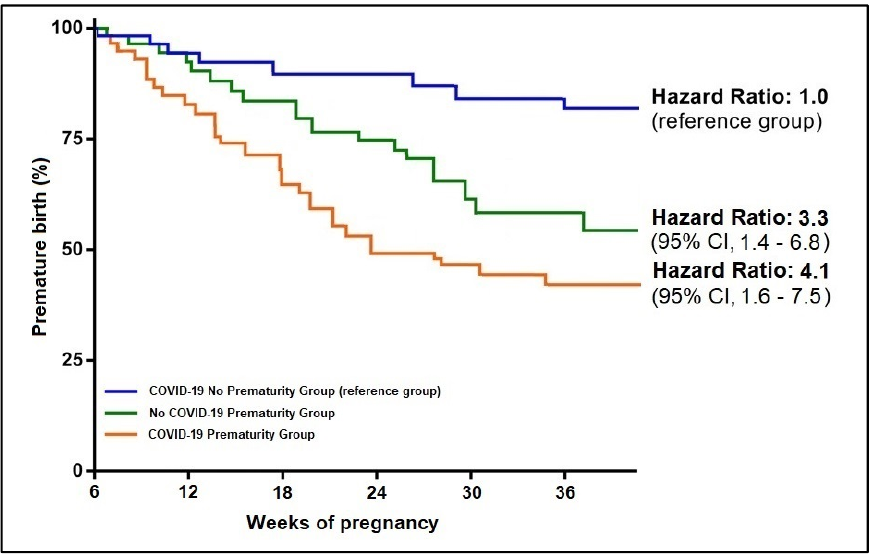
Figure 3. Kaplan-Meier probability analysis of premature birth by study group.